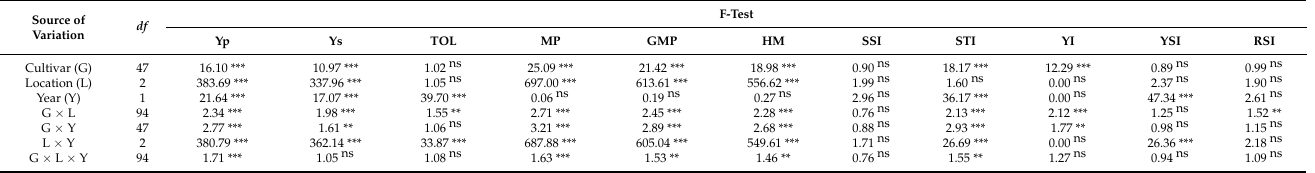
Table 1. Summary of the ANOVA (significance of the F-test) for the grain yield and stress screening indices. Sourceof Variation